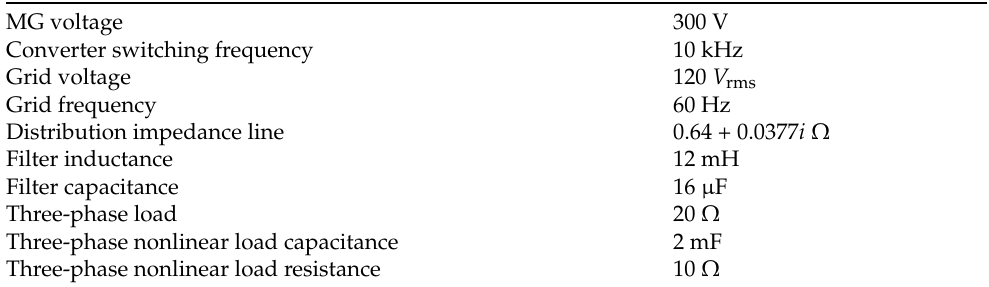
Figure 12. Experiment proposed to evaluate the IBC performance interfaced with an MG working in grid-tied mode. Table 4. MG experiment